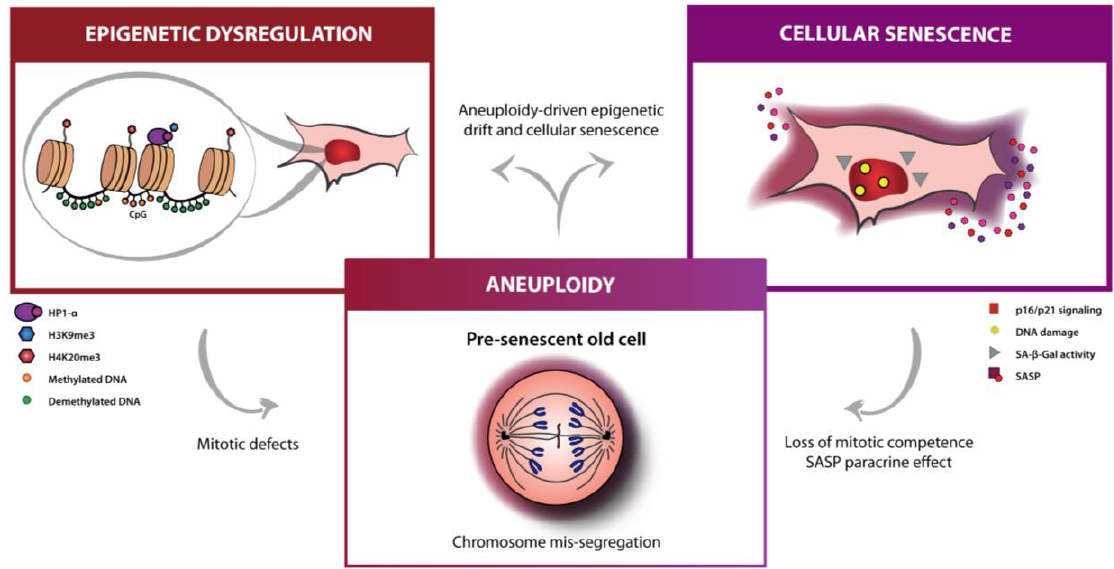
Figure 1. Epigenetic dysregulation, cellular senescence and aneuploidy: emerging targets for organismal rejuvenation and healthspan. Distinct changes in cells are observed during aging, including the accumulation of epigenetic alterations (global DNA demethylation and heterochromatinization, down-regulation of H3K9me3, up-regulation of H4K20me3, and delocalization of heterochromatin protein 1 α (HP1- α )) and an evolving proinflammatory senescent phenotype (with activation of DNA damage and p16/p21 signaling pathways, senescence-associated β -galactosidase activity and of a highly secretory phenotype). An emerging hallmark, age-associated aneuploidy results from a gradual down-regulation of the mitotic machinery along aging, perhaps driven by the other hallmarks, but also shown to elicit epigenetic alterations and cellular senescence.